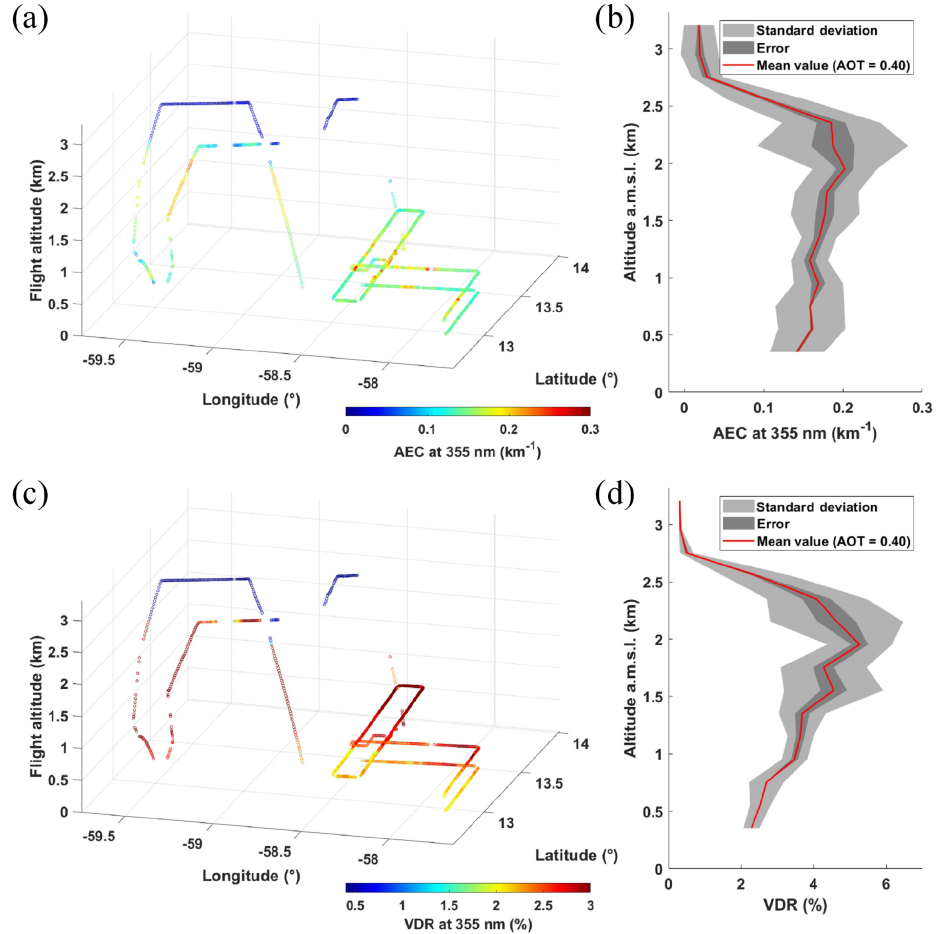
Figure 3. Same as Fig. 1 during flight F10 on 2 February 2020 at